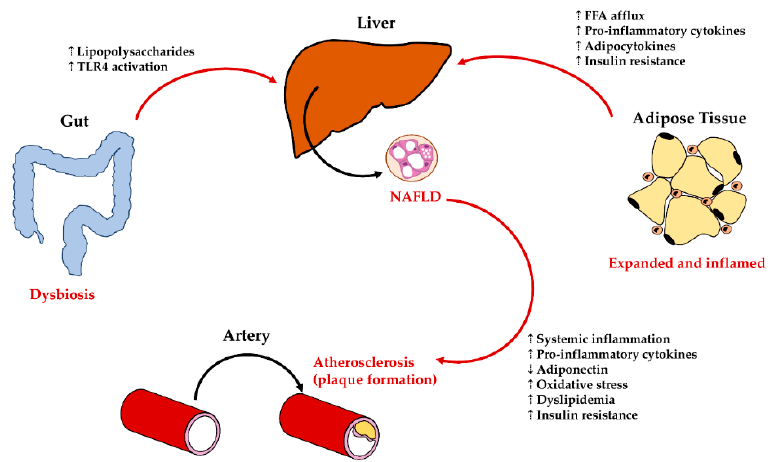
Figure 4. Interaction of liver damage with extra-hepatic organs. NAFLD is influences by interaction with other organs / tissues. Adipose tissue disarrangement (expansion / inflammation) induces increased Free Fatty Acid (FFA) a ffl ux to the liver and insulin resistance; moreover, it releases several pro-inflammatory cytokines and modifies the adipocytokine balance. Dysbiosis in the gut results in translocation of endotoxins (i.e., lipopolysaccharides) to the liver and the subsequent activation of the Toll-like Receptor (TLR) pathway in the liver. In turn, liver with NAFLD / NASH can influence atherosclerosis (plaque formation) by several mechanisms, including, but not limited to, systemic inflammation and oxidative stress